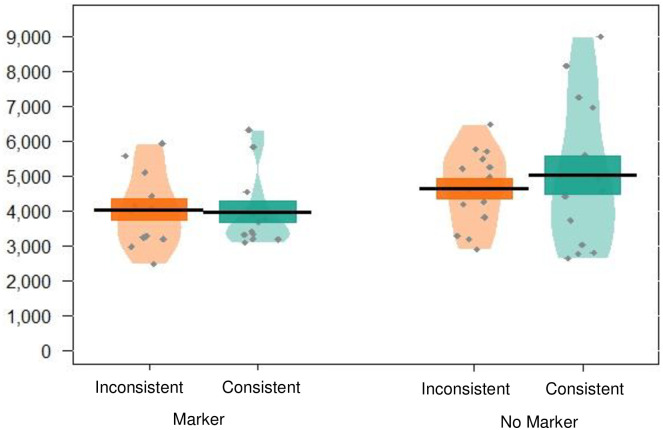
Pirate plot depicting the mean (raw) looking times to trials containing words from the same versus different categories for each condition.Black lines indicate the mean, and the coloured blocks indicate SE. The distribution of looking times is given for each group, with individual data points in grey.